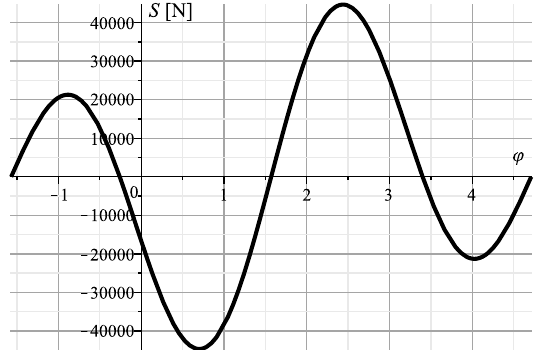
Figure 36: Plot of S ( φ ) (Example